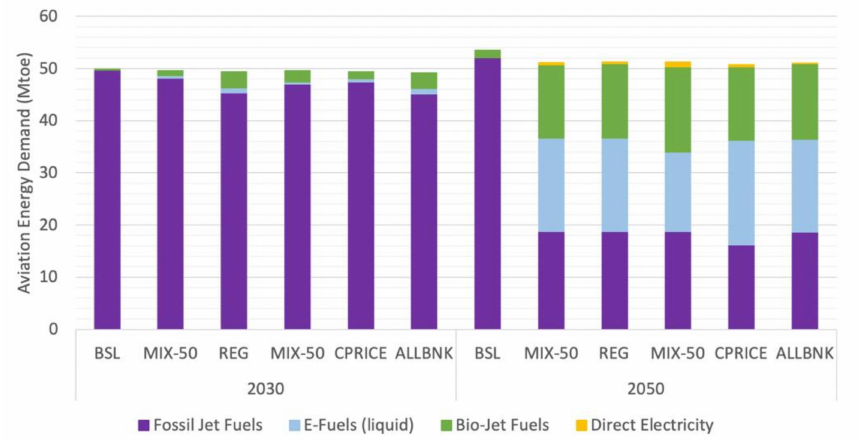
Figure 7. Aviation projected fuel mix for the policy scenarios considered in the Sustainable and Smart Mobility Strategy [45]. Figure has been elaborated by the authors based on data from